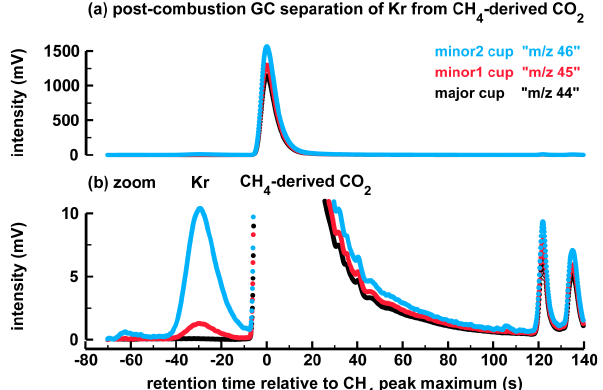
Fig. 10. Sample chromatogram showing the separation of Kr from CH 4 -derived CO 2 for the improved Bern system. (a) Full range plot of the narrow, cryofocused CH 4 -derived CO 2 peak and the broader N 2 O peak without cryofocusing step. (b) Zoomed plot to see the separation of Kr from CH 4 -derived CO 2 . The arrow “trap down” marks the time when the capillary is lowered into LN 2 to trap the CO 2 from the combustion oven. While CO 2 becomes trapped at LN 2 temperature, Kr passes the capillary without delay and shows the typical Kr interference signal.